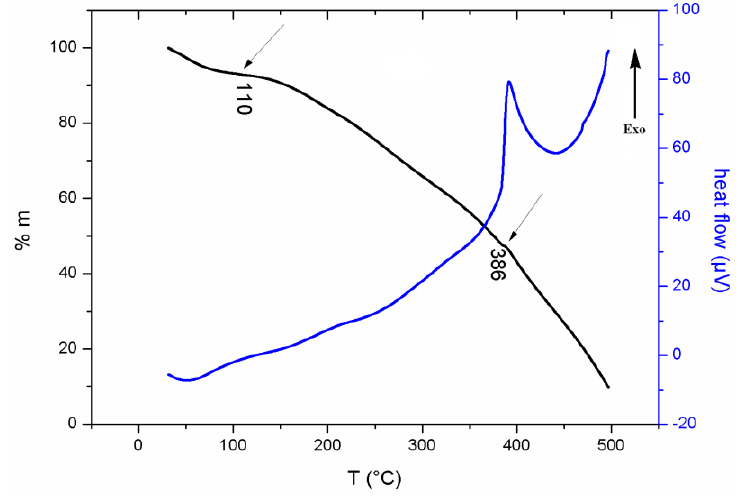
Figure 7. TGA and TDA thermogram of OBMPA under